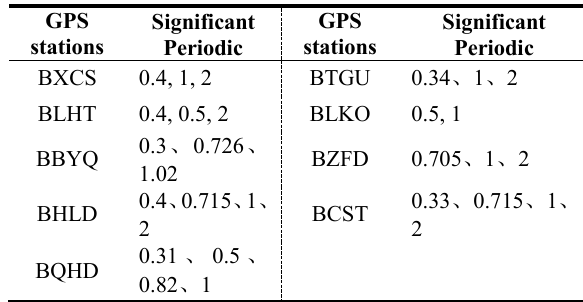
semi-annual and seasonal variation periods.